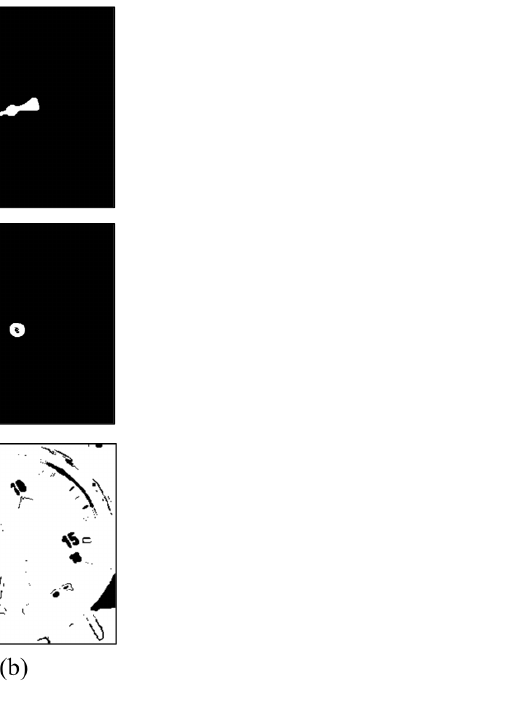
Figure 10. Application of the region growing. ( a ) Original image, ( b ) region growing